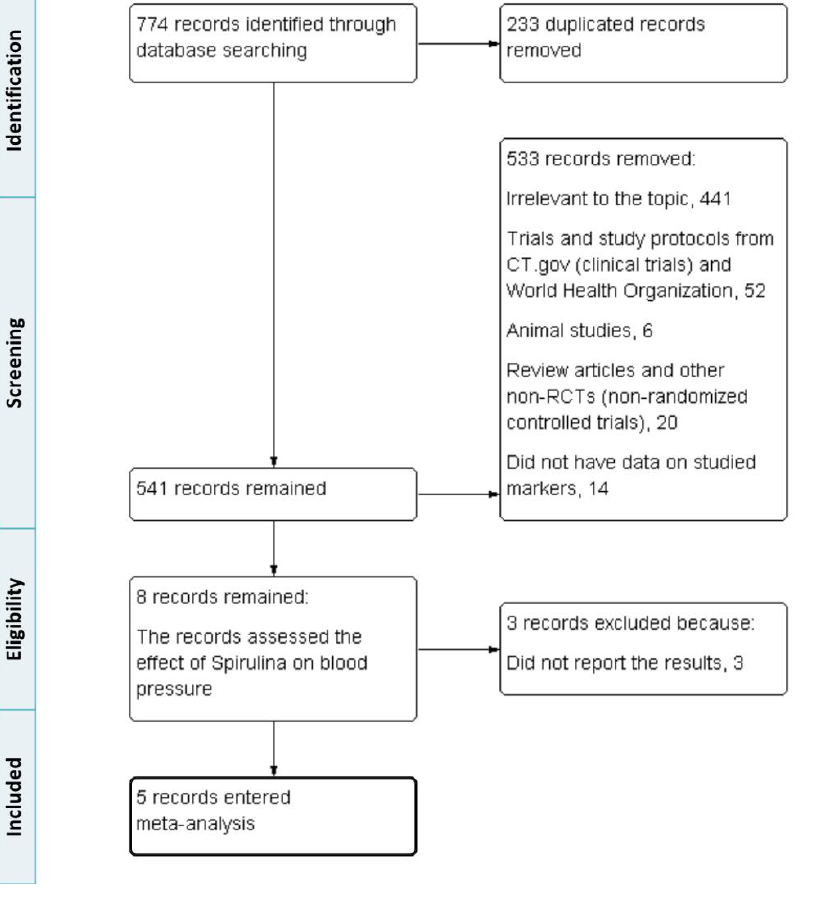
Figure 1. Preferred Reporting Items for Systematic Reviews and Meta-analyses (PRISMA) flow diagram of study identification, inclusion, and exclusion.